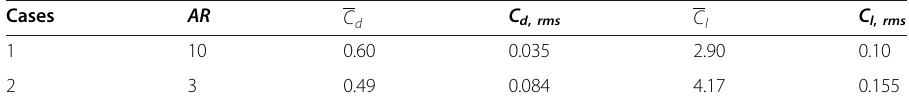
Table 2 Comparison of drag and lift coefficients of the single spinning cylinder with different aspect ratios